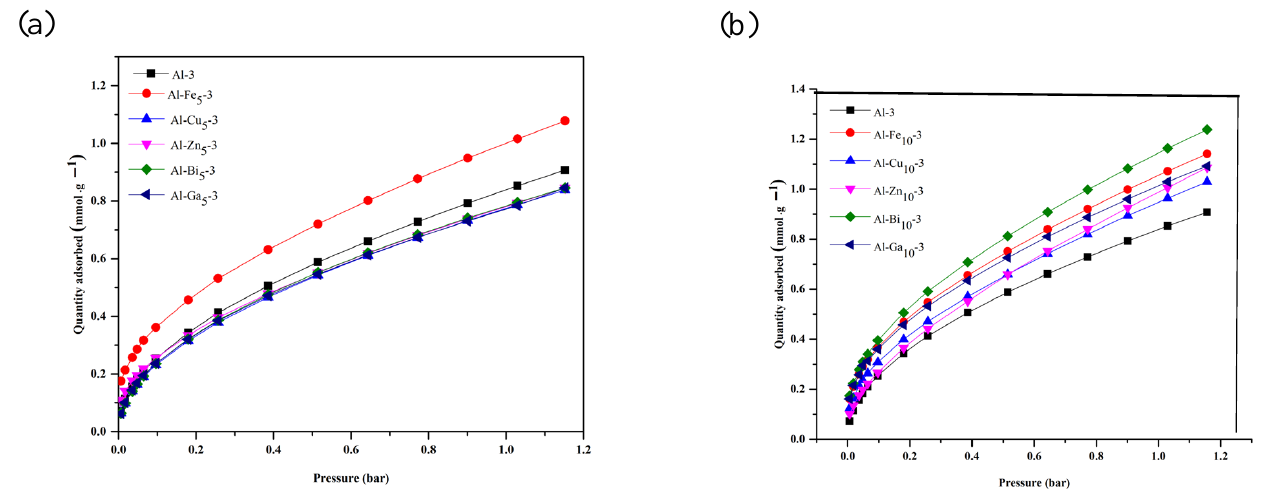
Figure 7. CO 2 adsorption isotherms measured at 25 °C for pristine alumina and metal oxide-incorporated samples: Al-MeO 5 -3 series ( a ) and Al-MeO 10 -3 series ( b ).